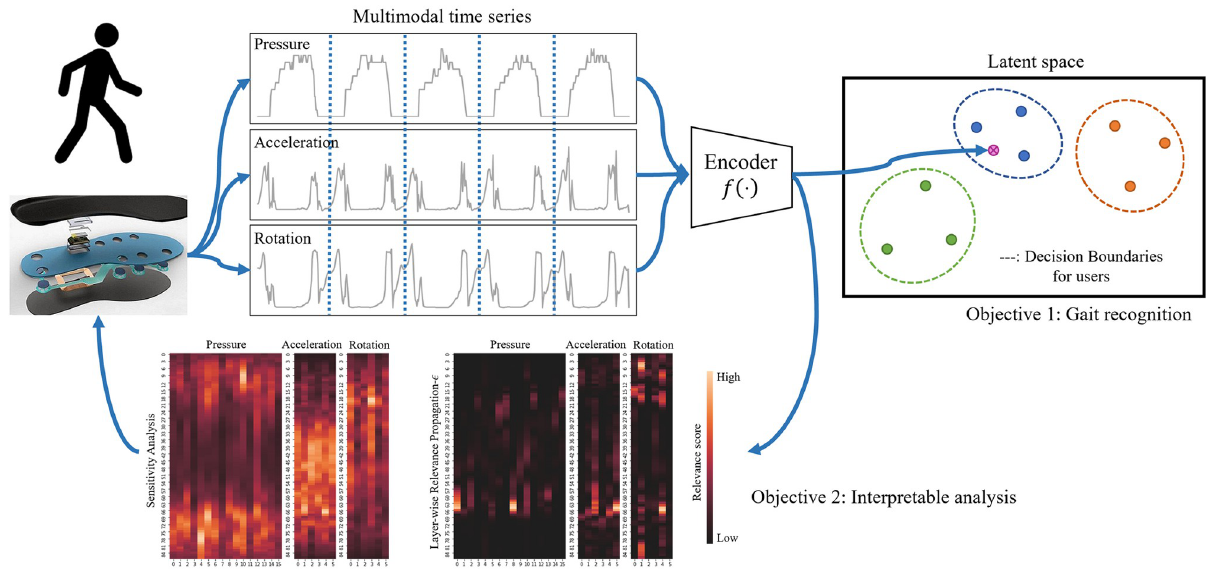
Fig 1. Illustration of the motivation and the objectives. Our study is to recognize a set of users from their gait patterns using a encoder network and to provide an interpretable analysis of the network using the XAI method.